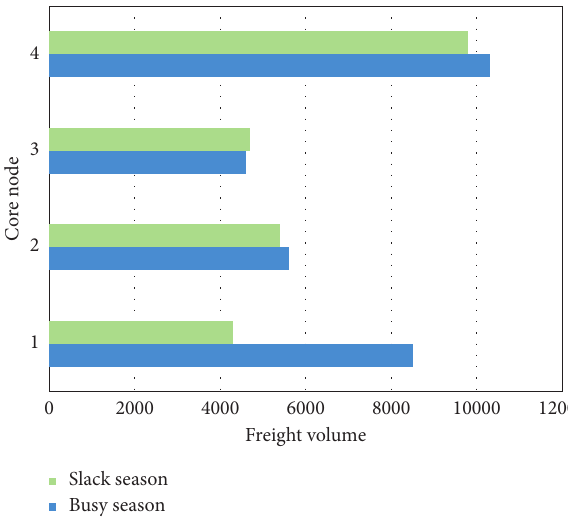
Figure 6: Freight volume distribution in the slack season and busy season at different core nodes. Note that node 4 faces a far smaller volume in the slack season than in the busy season, reflecting the strong purposefulness and seasonality of freight shipment by the consignor. During the busy season, more multimodal transport vehicles should be managed and deployed at the core nodes. During the slack season, these vehicles should be reduced at the core nodes. This is a necessary strategy for the planning, investment, and construction of the multimodal transport network. Reasonable planning, investment, and construction could reduce the operation cost of the multimodal freight transport network and ease the irrational distribution of vehicles. Table 1: Time windows of freight